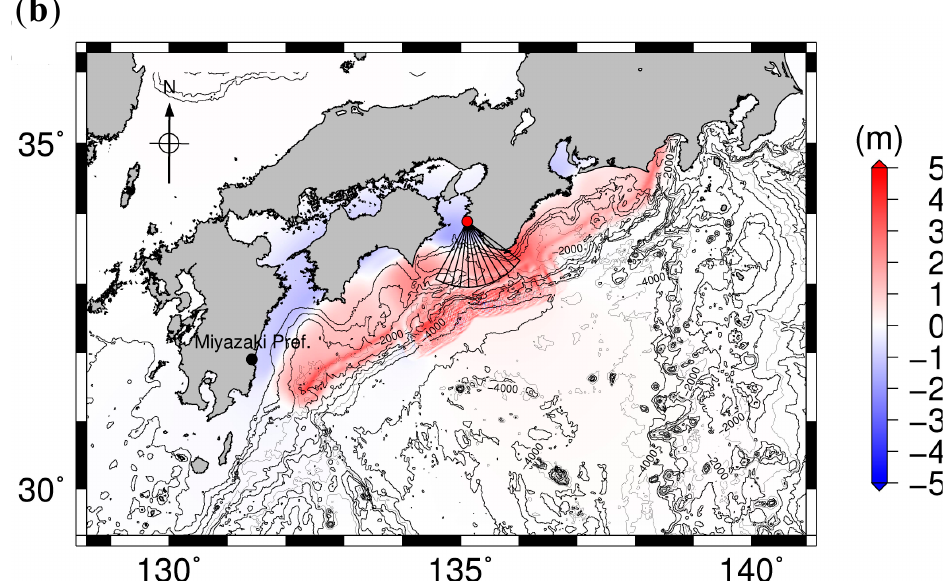
Figure 1. ( a ) Observation area of the high-frequency (HF) radar installed on the Mihama coast and the depth contours of the Kii channel. The red circle represents the radar station; ( b ) initial sea surface elevation of the tsunami induced by the Japan Cabinet Office’s fault model case 3.